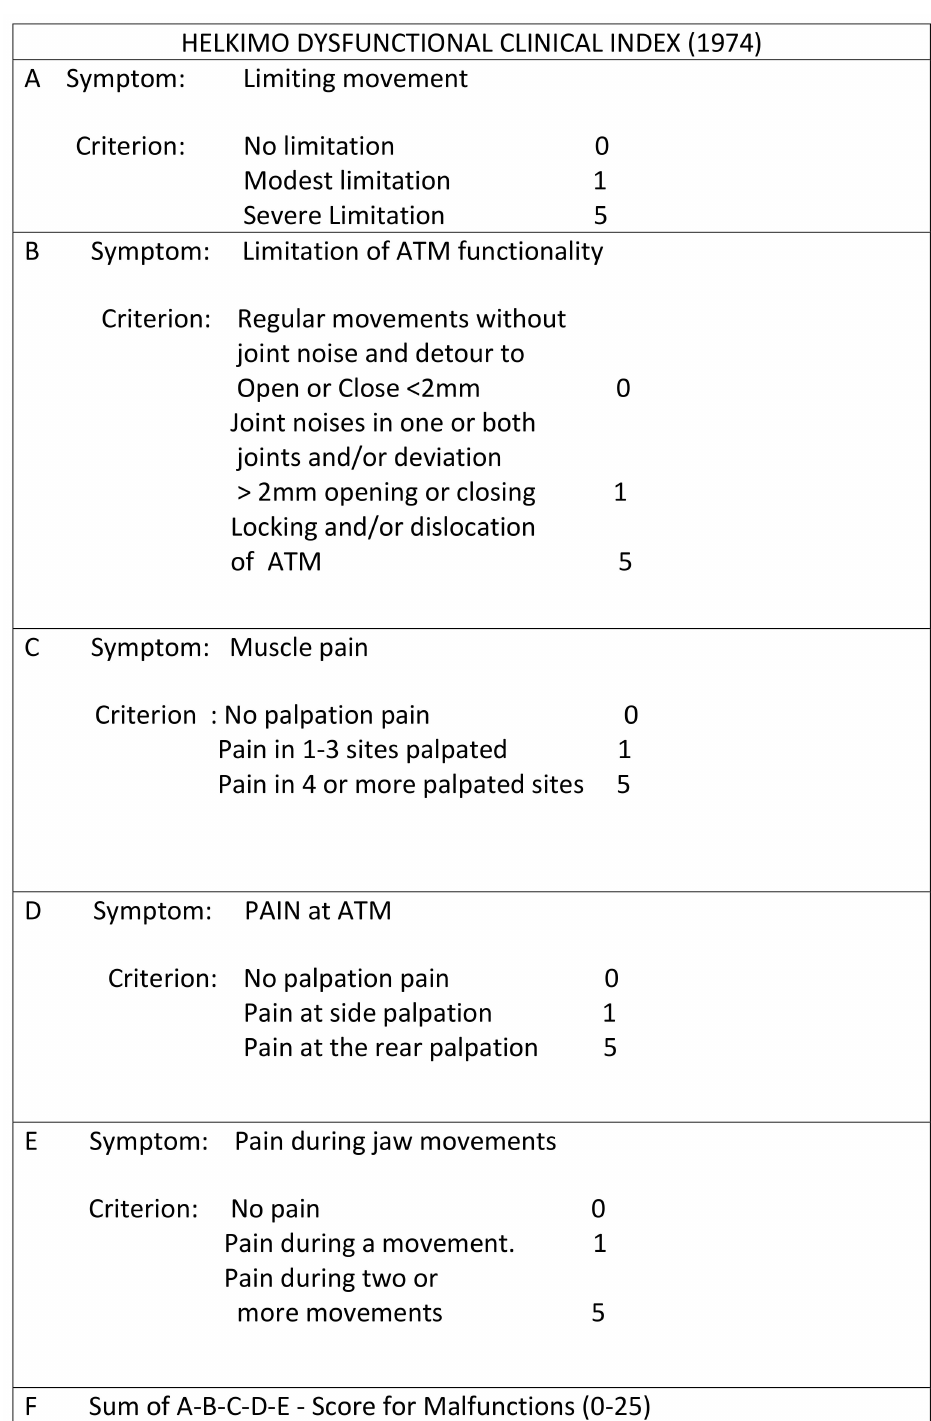
Figure 2. Example of the Helkimo clinical dysfunction index questionnaire filled out by one included